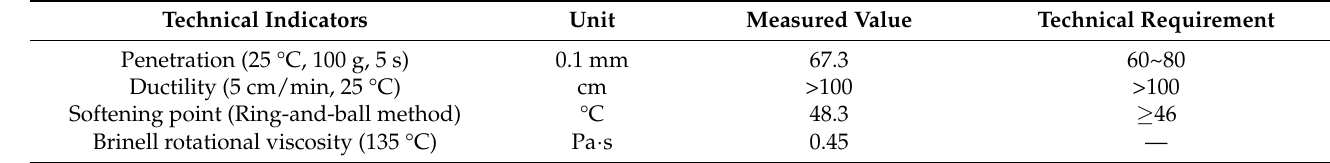
Table 1. Basic technical indexes of base